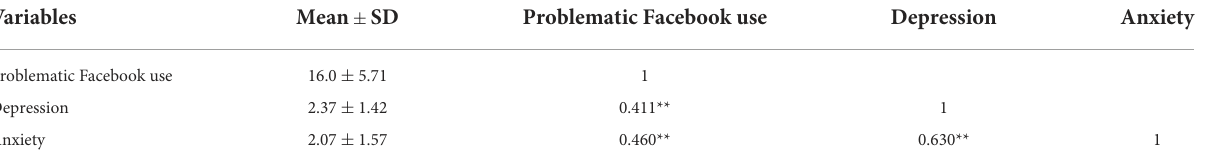
TABLE 2 Correlation coefficients between continuous variables and problematic Facebook